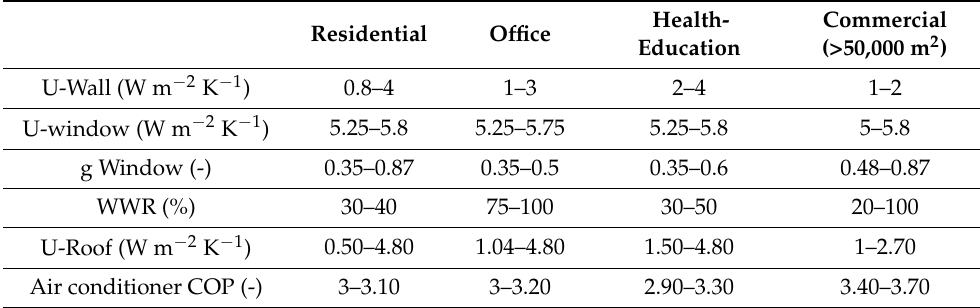
Table 5. Summary of envelope ranges for different type of buildings in Panama